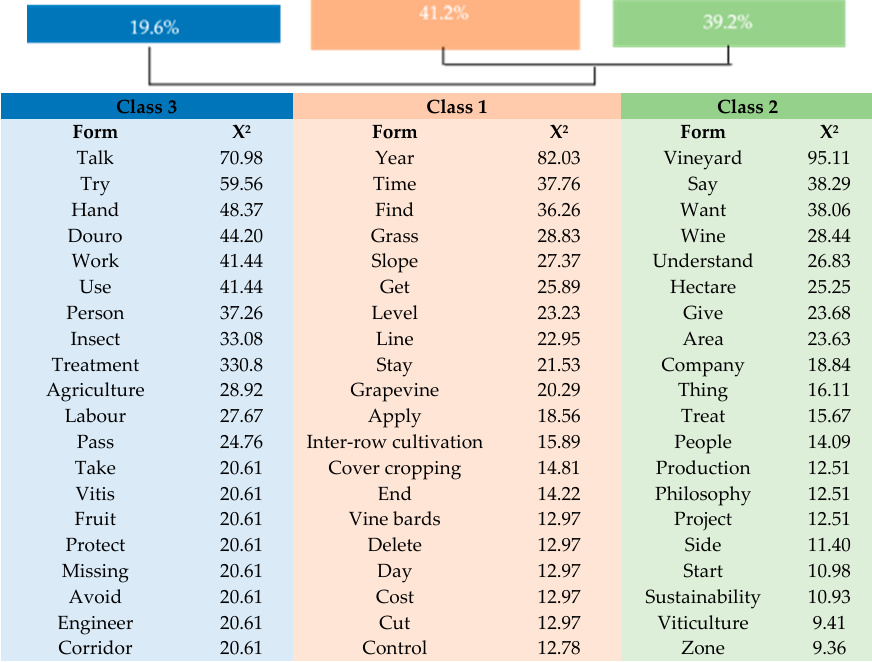
Figure 1. Classification of the interviewees’ speeches according to DHC. Source: research data analysed by the Iramuteq software. Class 2, designated “global winemakers” (39.2% of the interviewees), has a discourse centred on winegrowing (using words such as “vineyard”, “wine”, “viticulture”) at a cer- tain production scale (illustrated with words such as “hectare”, “area”, “production”),